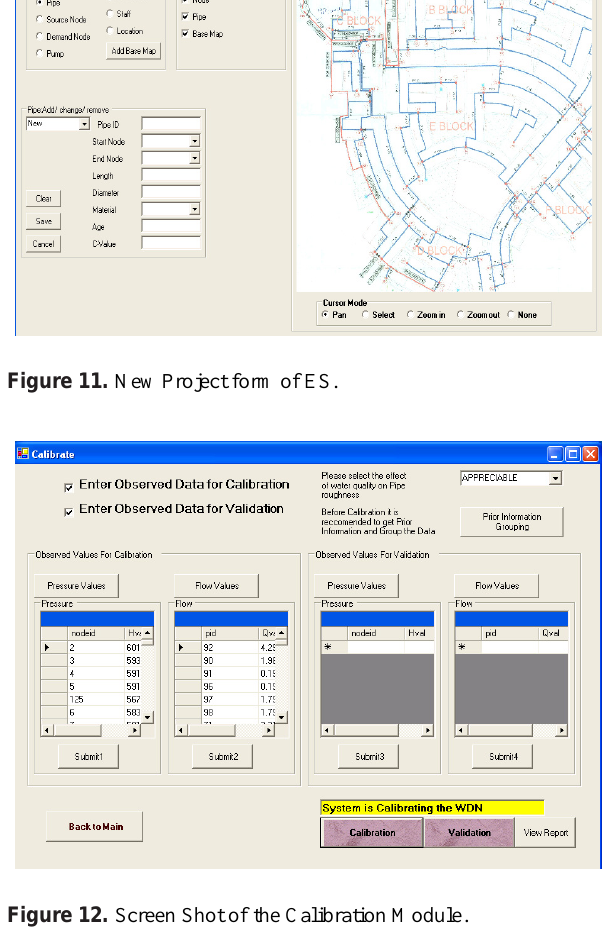
Fig. 12. Screen Shot of the Calibration Module